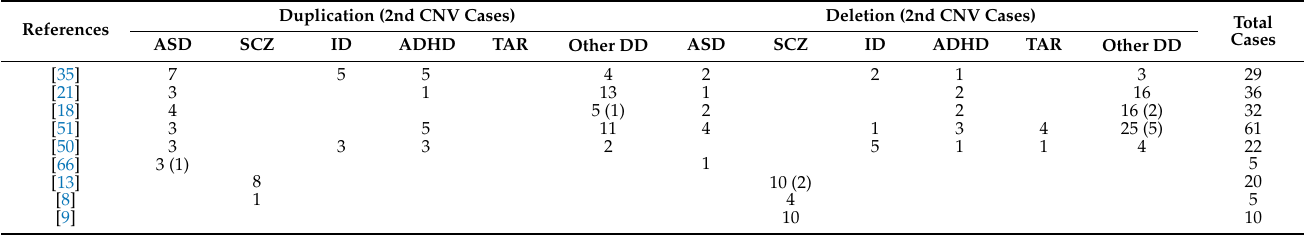
Table 2. Case reports of neurodevelopmental diseases with 1q21.1 duplications and